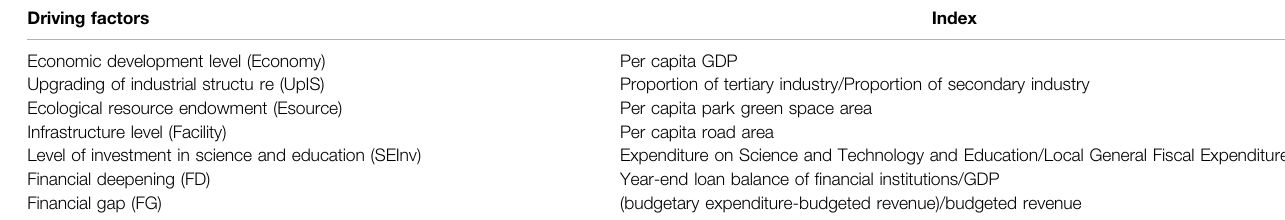
TABLE 2 | Driving factors.